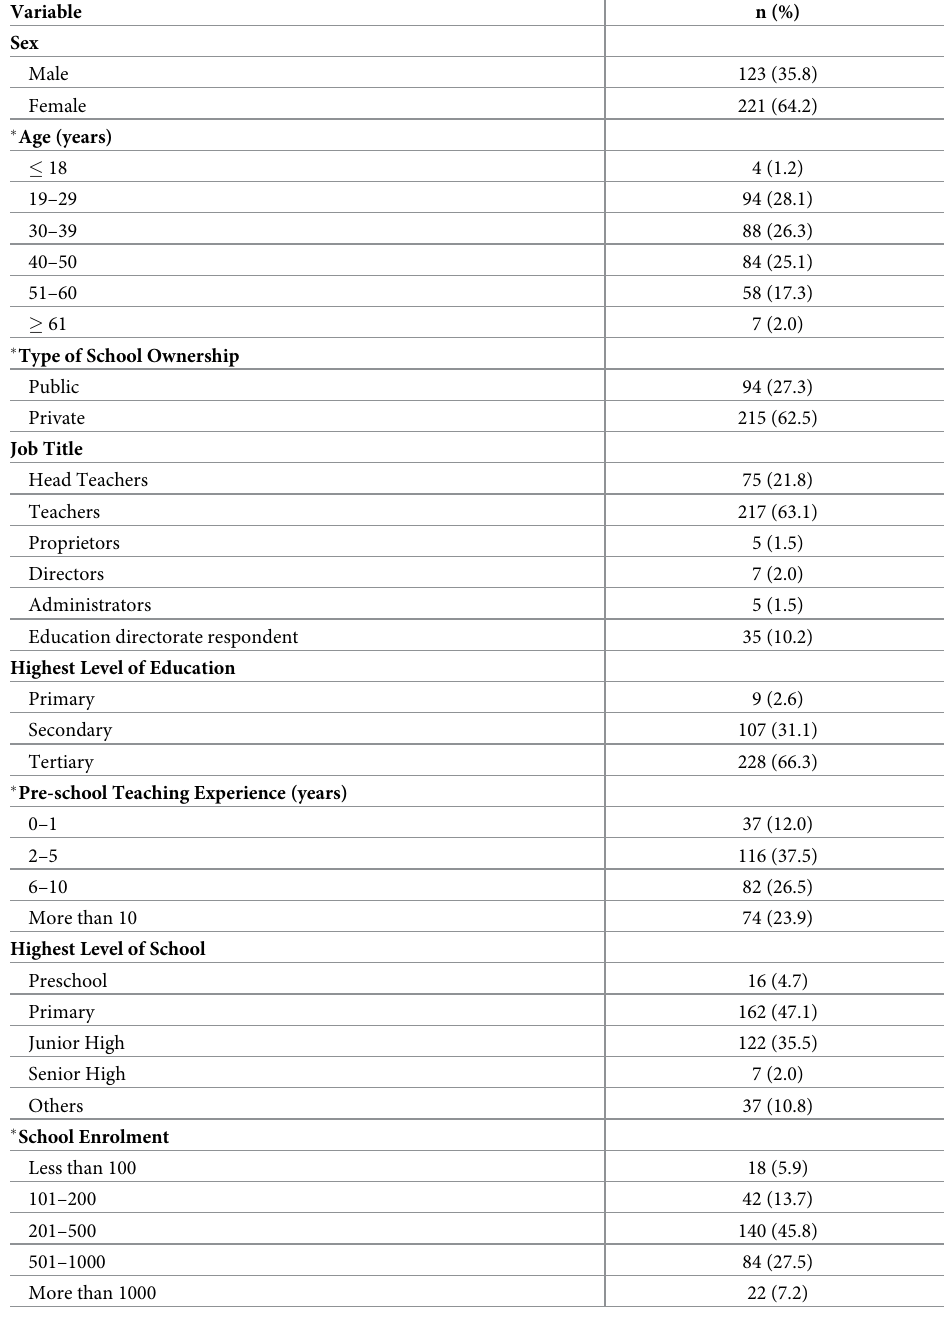
Table 1. Demographic characteristics of